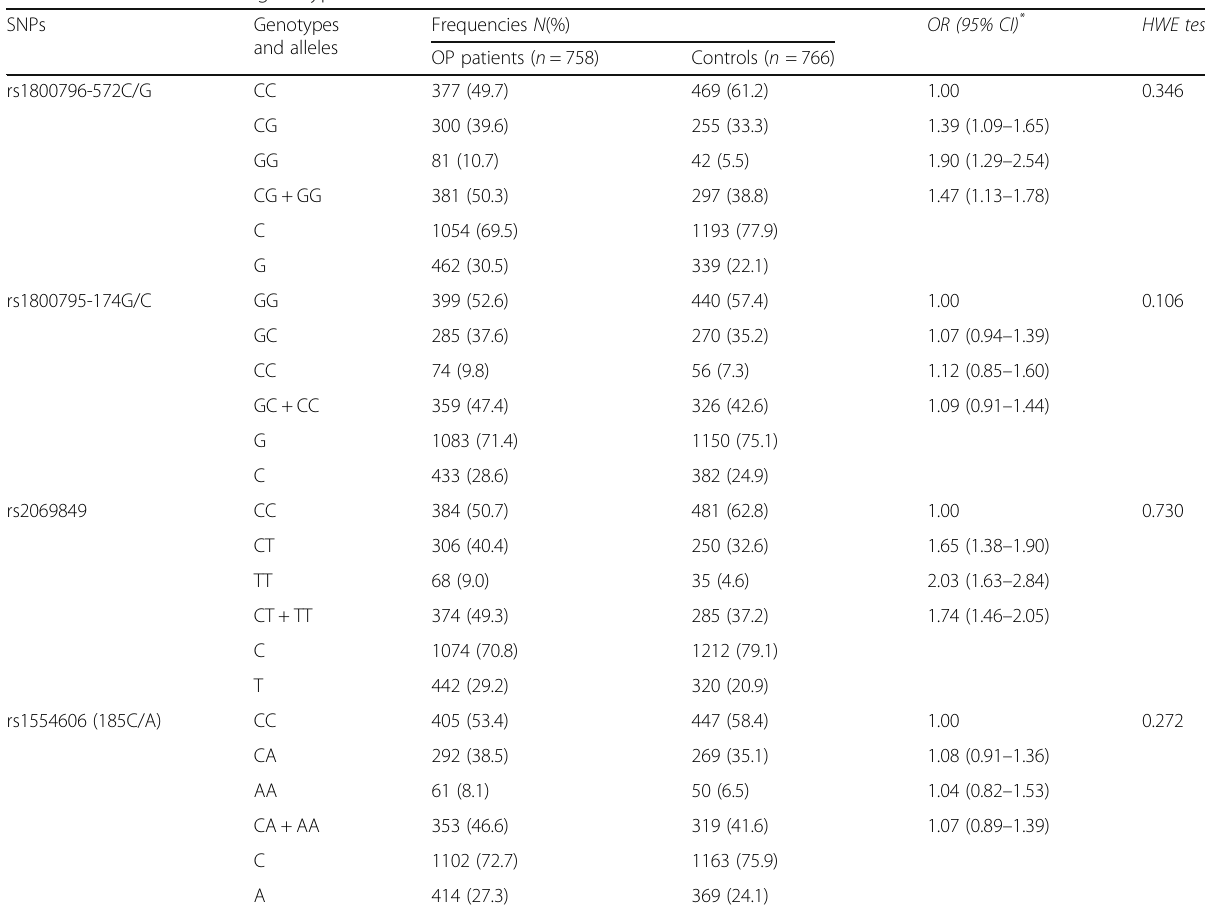
Table 3 The association of genotype and allele within four SNPs with OP risk